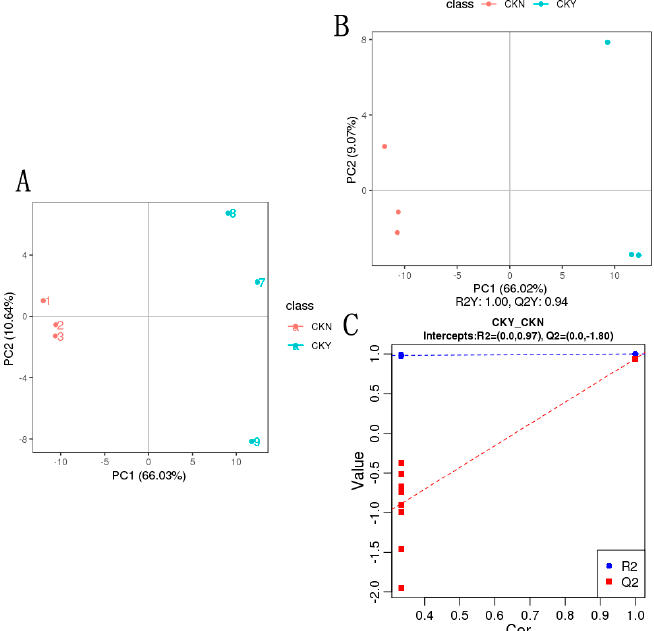
Figure 5. Principal component analysis (PCA) and partial least squares discrimination analysis (PLS-DA) of the CKY versus CKN comparison. PCA ( A ). PLS-DA score map ( B ). Replacement test ( C ).